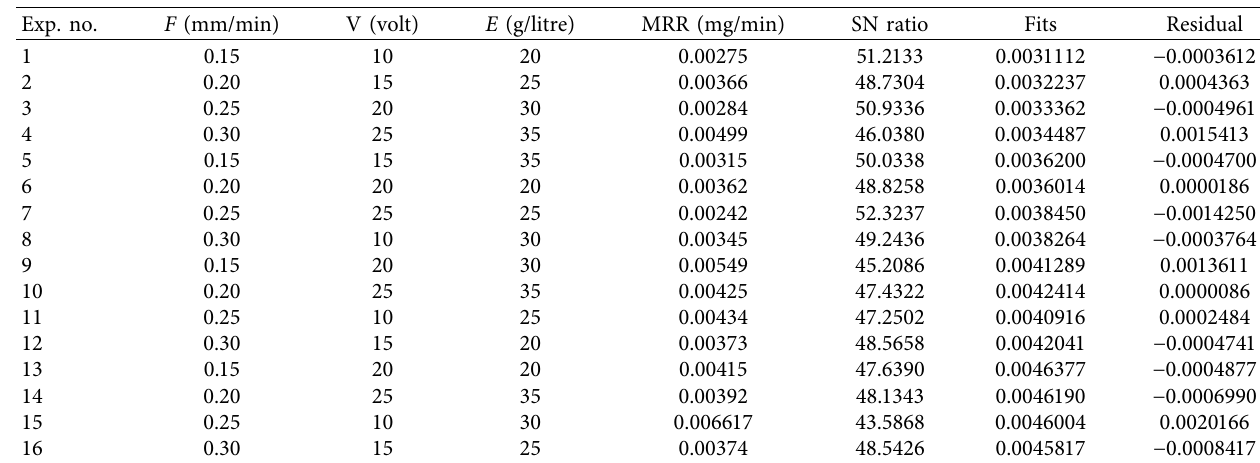
Table 4: Measured responses of